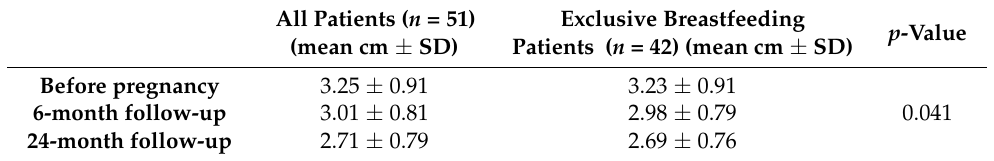
Table 3. Size of ovarian endometriomas before pregnancy and at 6- and 24-month follow-up periods. All Patients ( n = 51)